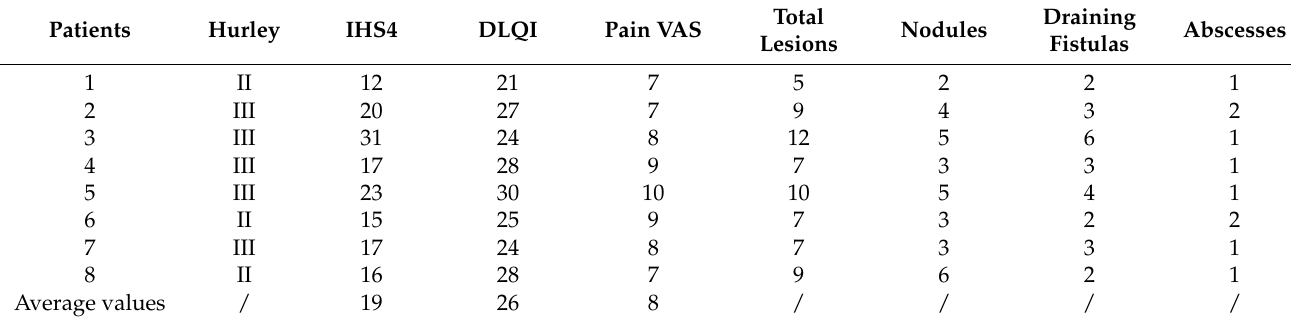
Table 2. Clinical assessment at baseline